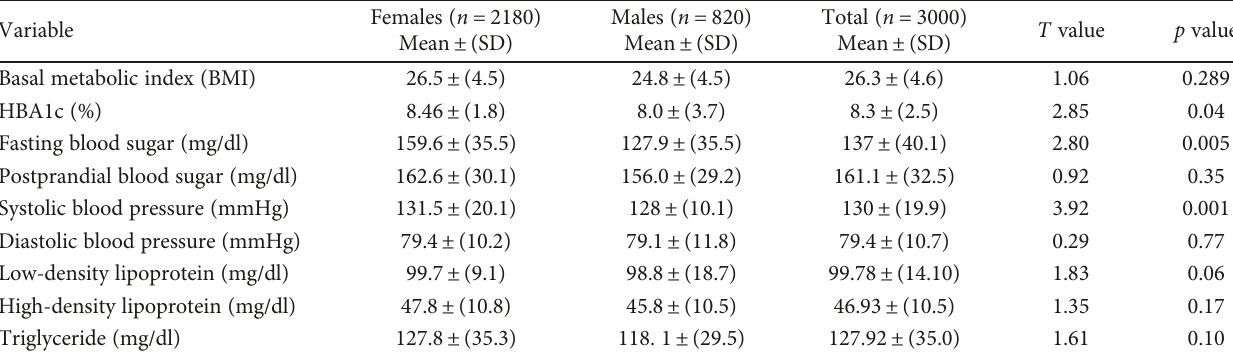
Table 1: Metabolic pro fi le and its signi fi cance to the study population by